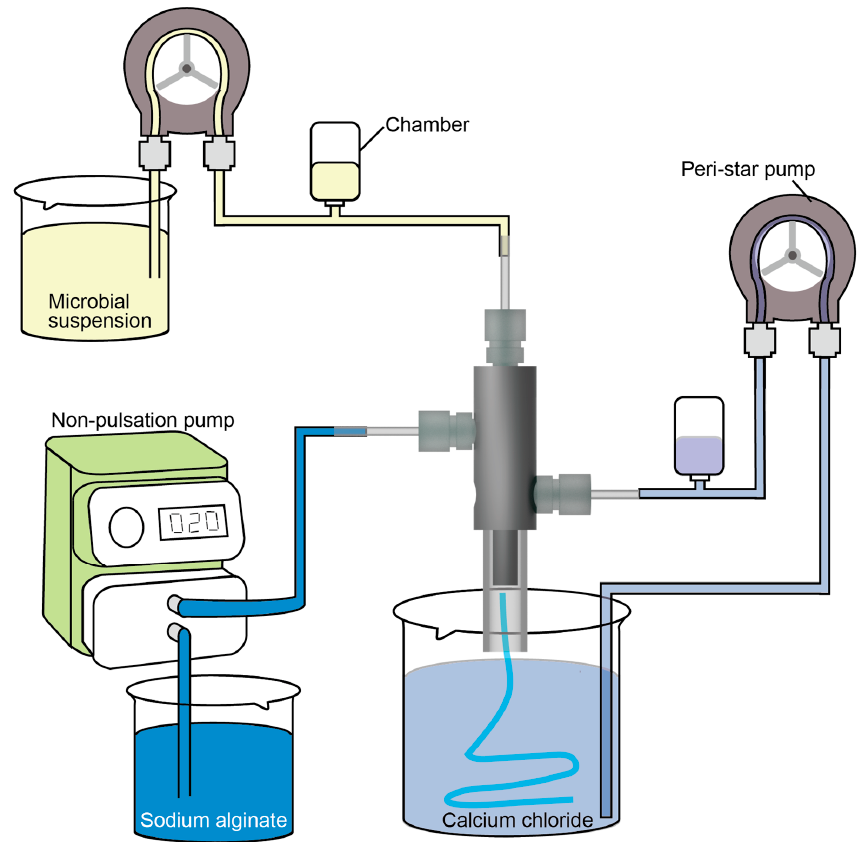
Figure 4. Experimental setup for production of microtubes.